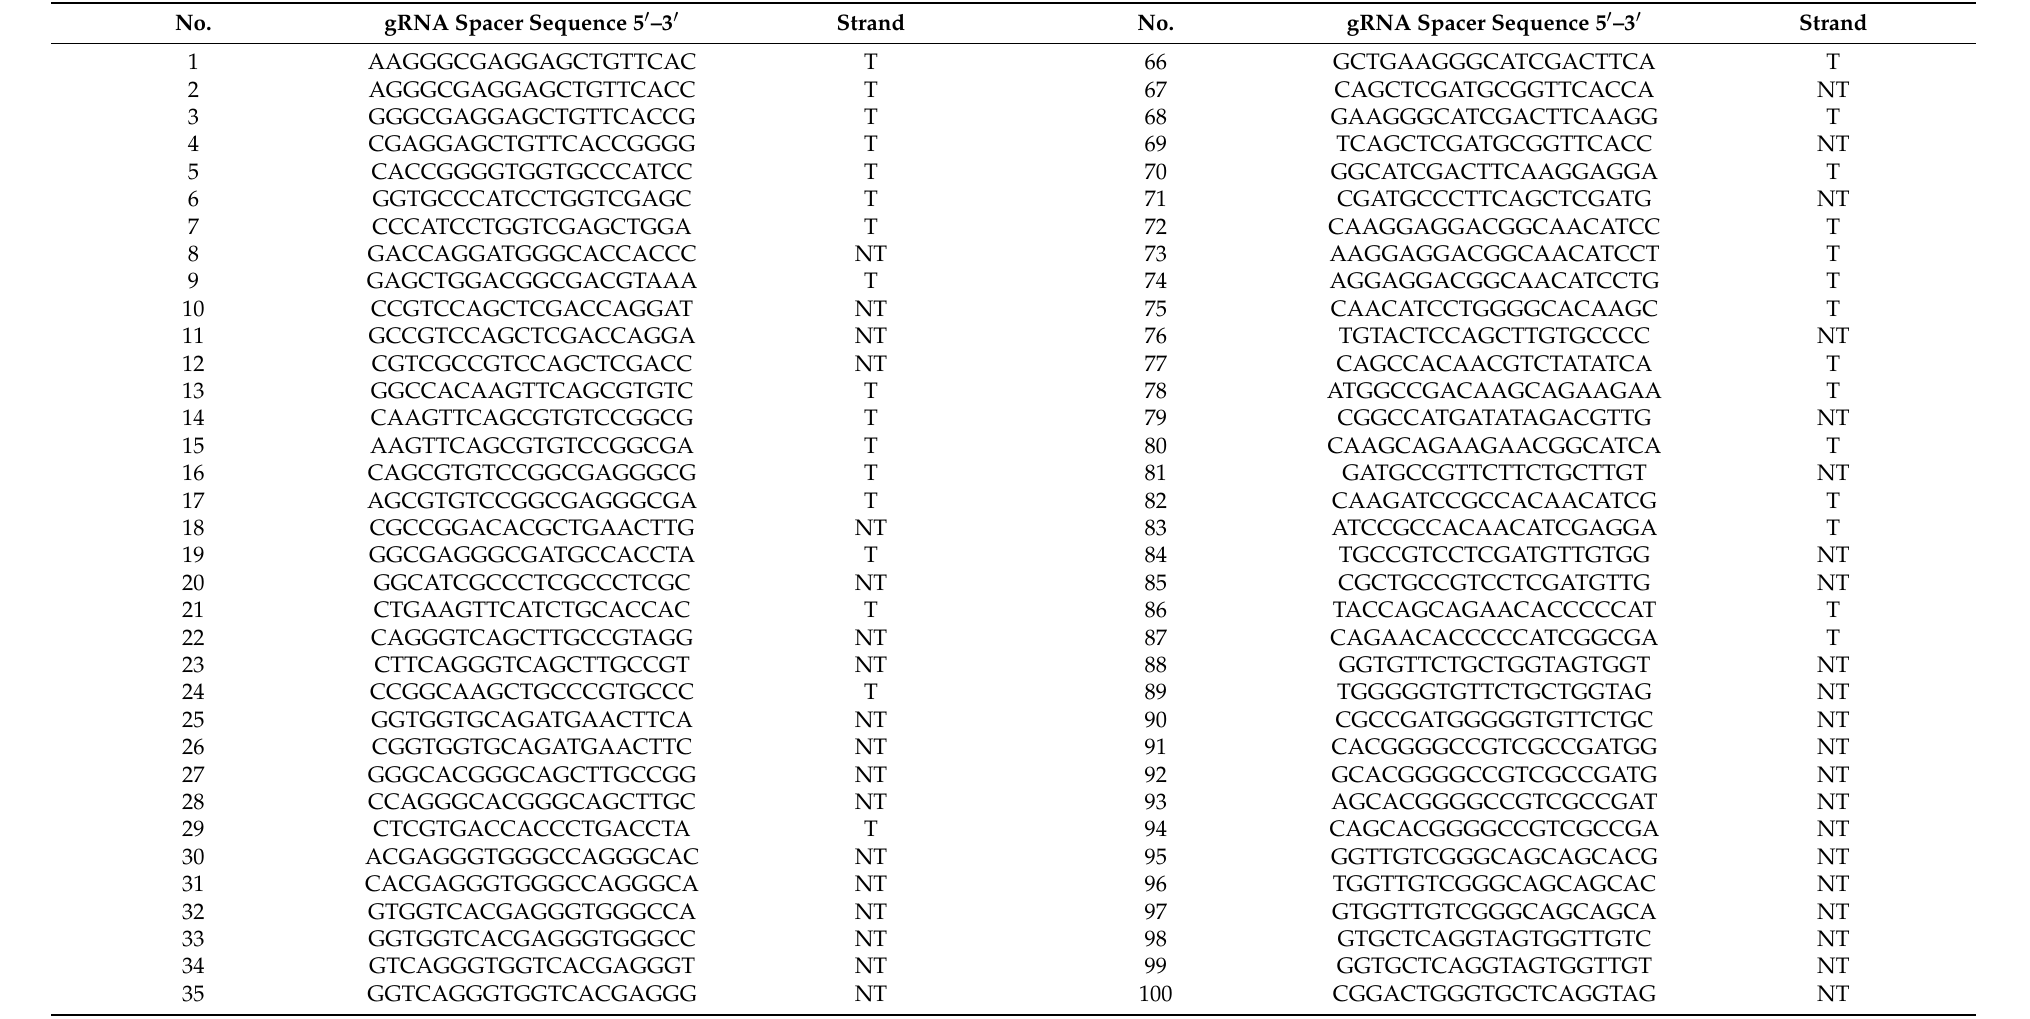
Table 1. gRNA space sequences targeting d2EGFP coding region (No. 1 to 119) and CMV promoter (No. 120 to